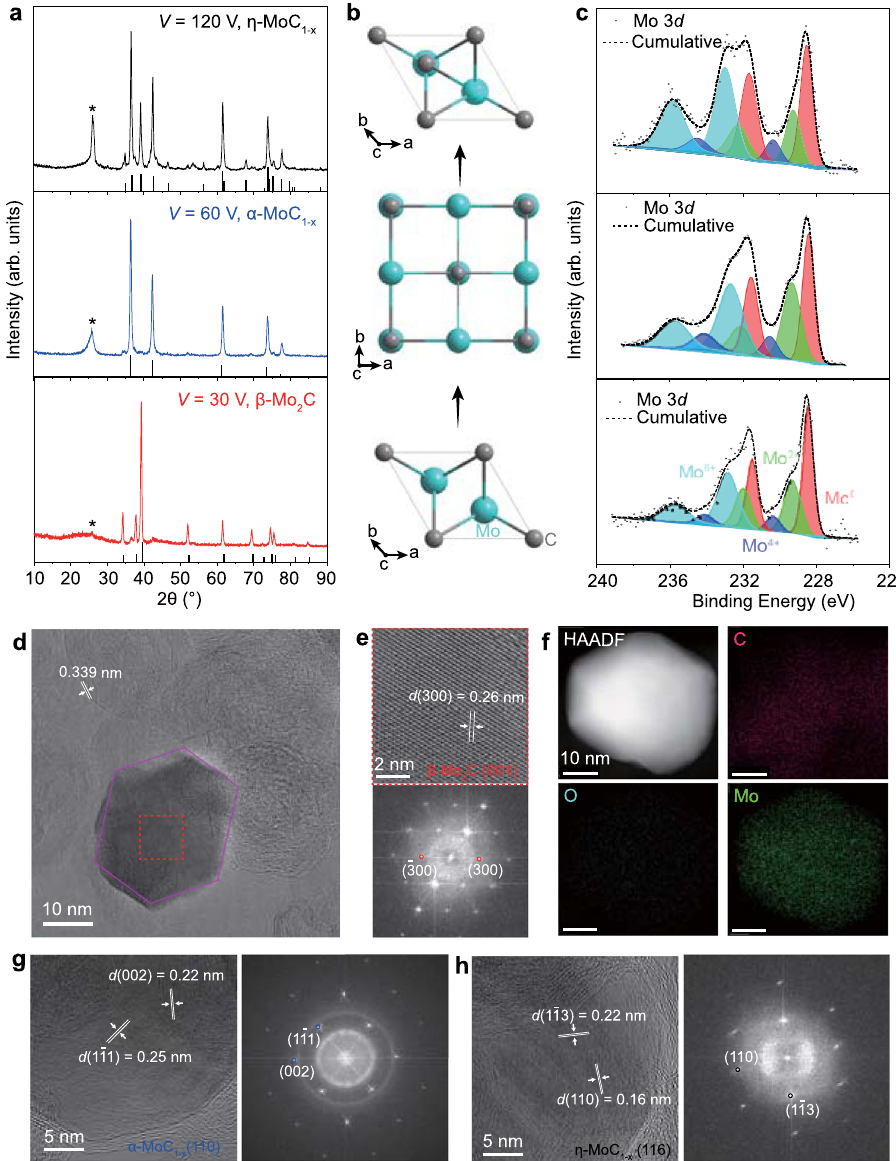
Fig. 2 Phase controlled synthesis of molybdenum carbide. a X-ray diffraction (XRD) patterns of β -Mo 2 C, α -MoC 1-x , and η -MoC 1-x synthesized at voltage ( V ) of 30 V, 60 V, and 120 V, respectively. The PDF reference cards for each are β -Mo 2 C, 35 – 0787; α -MoC 1-x , 65 – 8092; and η -MoC 1-x , 08 – 0384. The peak at ~26° (star) is attributed to graphene support. b , Crystal structures of three phases of molybdenum carbides. β -Mo 2 C is hexagonal with ABAB stacking (bottom), α -MoC 1-x is cubic (middle), and η -MoC 1-x is hexagonal with ABCABC stacking (top). c X-ray photoemission spectroscopy (XPS) spectra of three phases of molybdenum carbides. d Bright- fi eld transmission electron microscopy (BF-TEM) image of a β -Mo 2 C nanocrystal supported on graphene. The 0.339 nm corresponds to interplanar distance ( d ) of graphene. The purple hexagon depicts the shape of the nanocrystal. e High-resolution transmission electron microscopy (HRTEM) image of β -Mo 2 C (top) and corresponding fast Fourier transform (FFT) pattern (bottom). f High-angle annular dark- fi